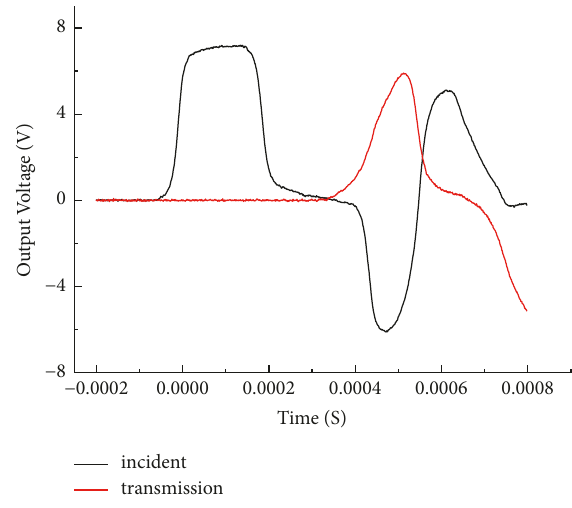
Figure 3: Typical waveforms at high strain